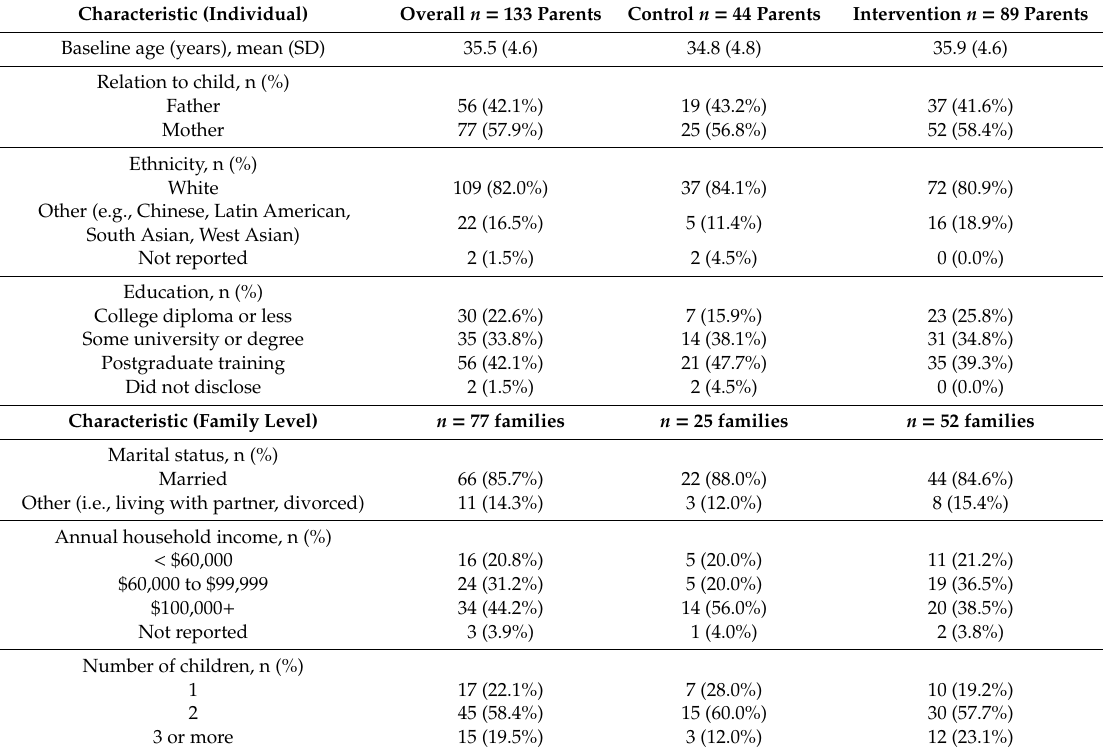
Table 1. Baseline characteristics of parent participants in the Guelph Family Health Study.